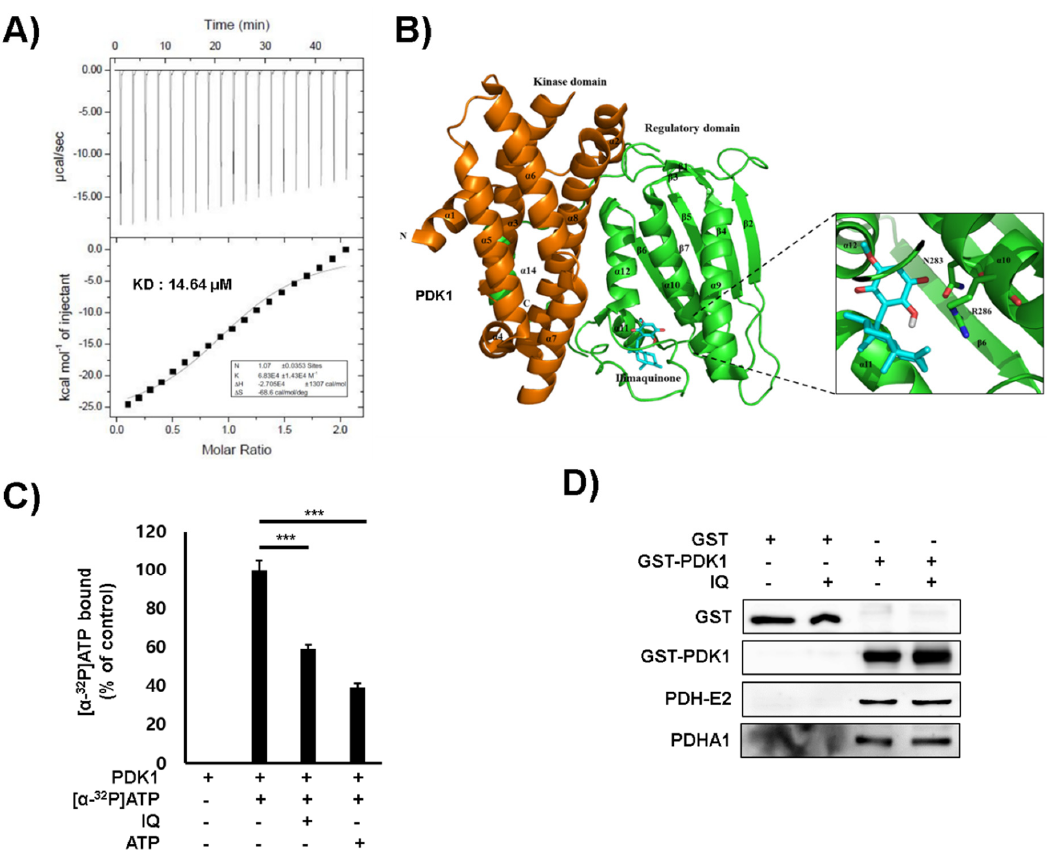
Figure 3. IQ interacted with the ATP binding pocket of PDK1. ( A ) The ITC analysis results of PDK1 and IQ are shown. IQ was titrated into PDK1 solutions, and the measured Kd values are shown. ( B ) IQ binds to the ATP binding pocket of PDK1. The modeled structure of PDK1 with IQ is shown as a ribbon diagram. The interaction residues between PDK1 and IQ are shown. ( C ) The ATP binding assay results of PDK1 and IQ are shown. The binding of ATP to PDK1 in the presence of IQ was determined using α 32 -labeled ATP. Non-bound α - 32 P-GTP was washed out, and the radioactivity was examined using a scintillation counter. Non-labeled ATP was used as a competitor. Data are presented as the mean ± SD. Statistical analyses were performed using Student’s t -test. *** p < 0.001 compared with the control under α 32 -labeled ATP (second column). ( D ) The PDC subunits and PDK binding were analyzed.